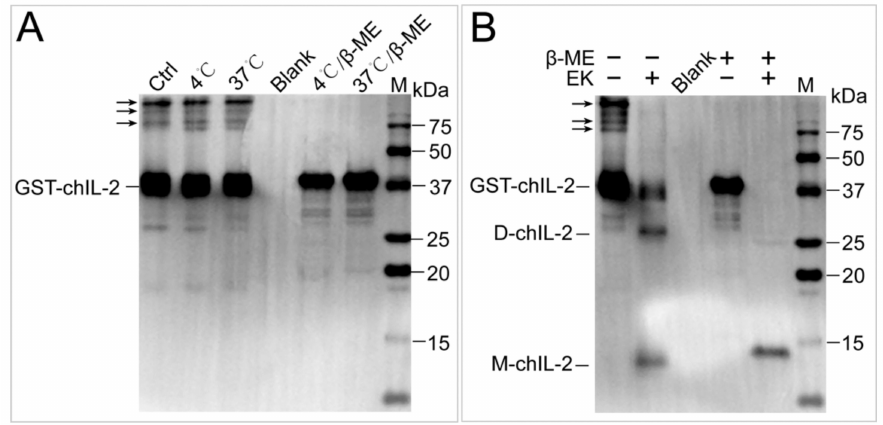
Figure 4. The e ff ect of GST tag on dimerization of chIL-2. ( A ), the e ff ect of temperature and β -ME on GST-chIL-2 dimerization. ( B ), the e ff ect of β -ME on the dimerization of chIL-2 generated by cleavage of GST tag. EK, enterokinase. M, protein standard marker. Ctrl, chIL-2 without temperature and β -ME treatment. Blank, 1 × loading bu ff er without reducing agent and chIL-2